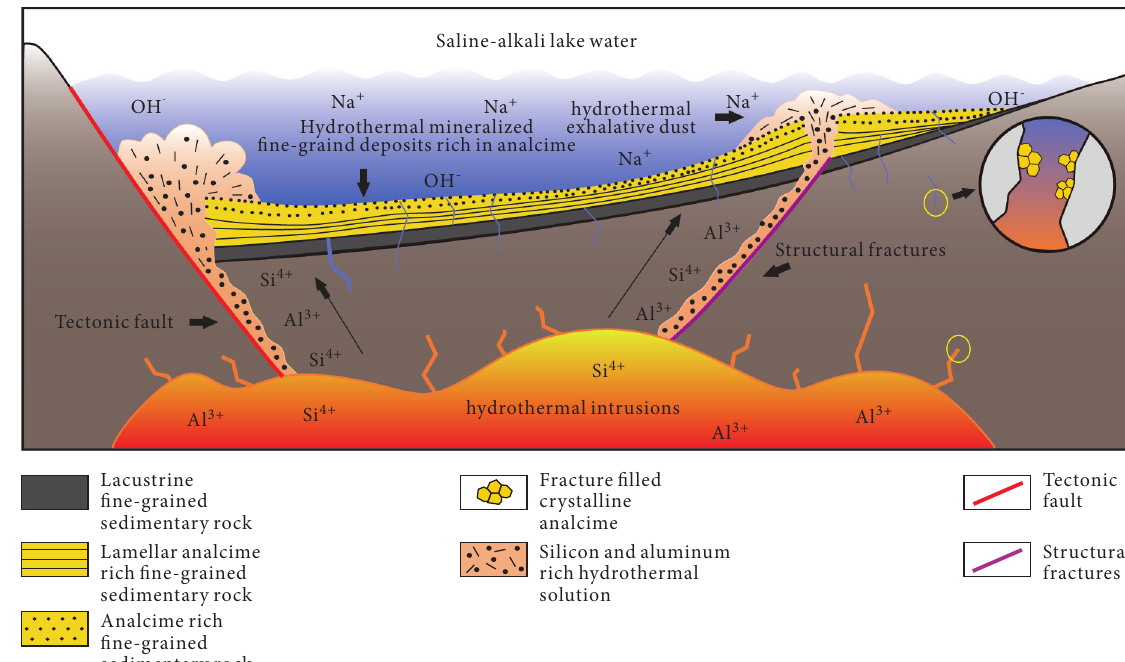
Figure 10: Schematic of hydrothermal sedimentary mineralization of analcime (modified according to Su et al., 2019)